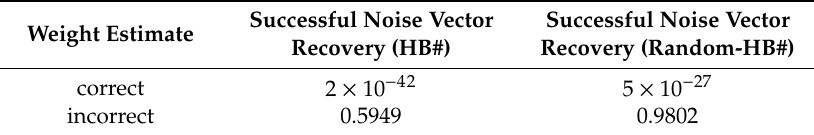
Table 3. Probability of successful noise vector recovery for HB# and Random-HB# protocols using the OOV algorithm, depending on the correctness of the initial weight estimate. Paradoxically, a noise vector can e ff ectively be recovered only if its weight has initially been incorrectly